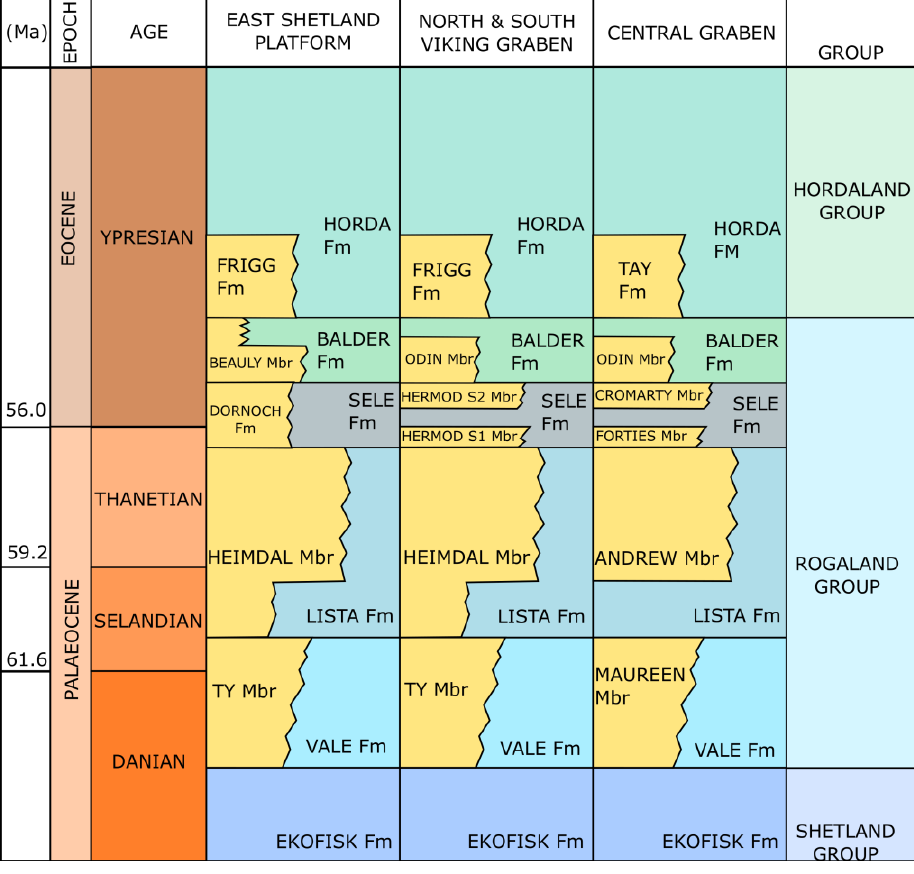
Figure 2. Stratigraphy of the Palaeogene interval of the investigated area showing the sandstone formations and members discussed in the text (sandstones shown in yellow). Other regions shown for correlation. Modified after Brunstad et al. [3], Deegan and Scull [40] and Hartog et al. [1].